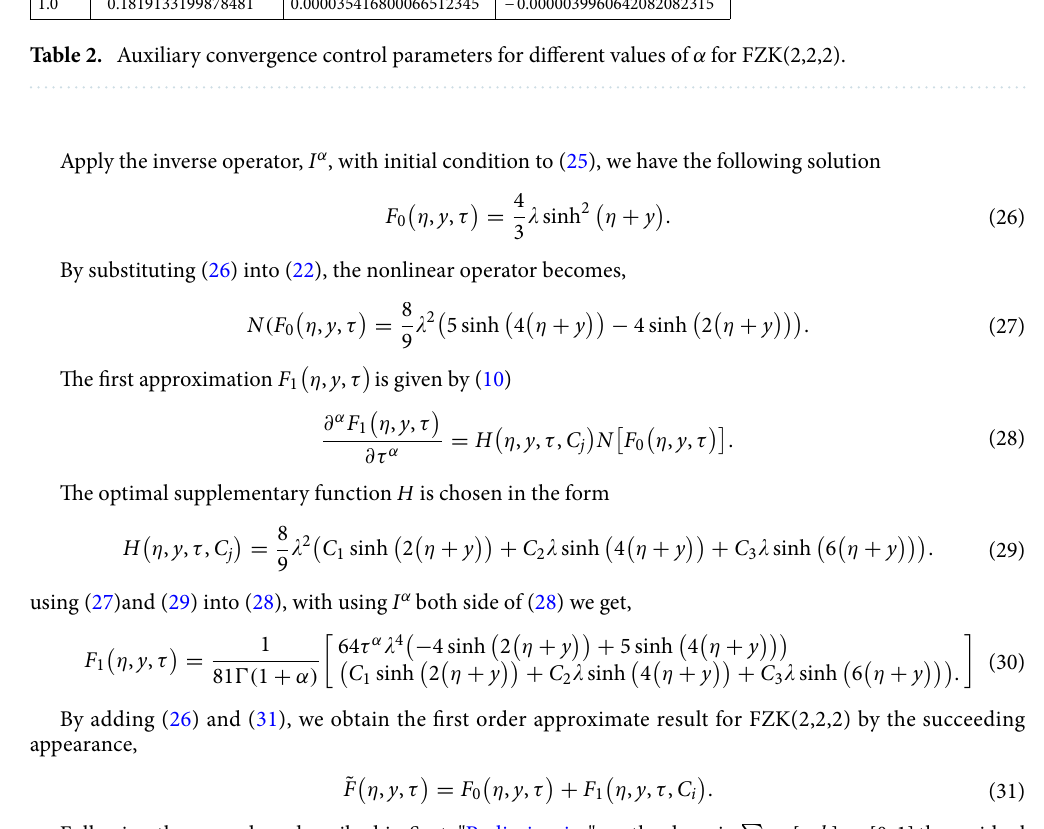
Following the procedure described in Sect. "Preliminaries" on the domain